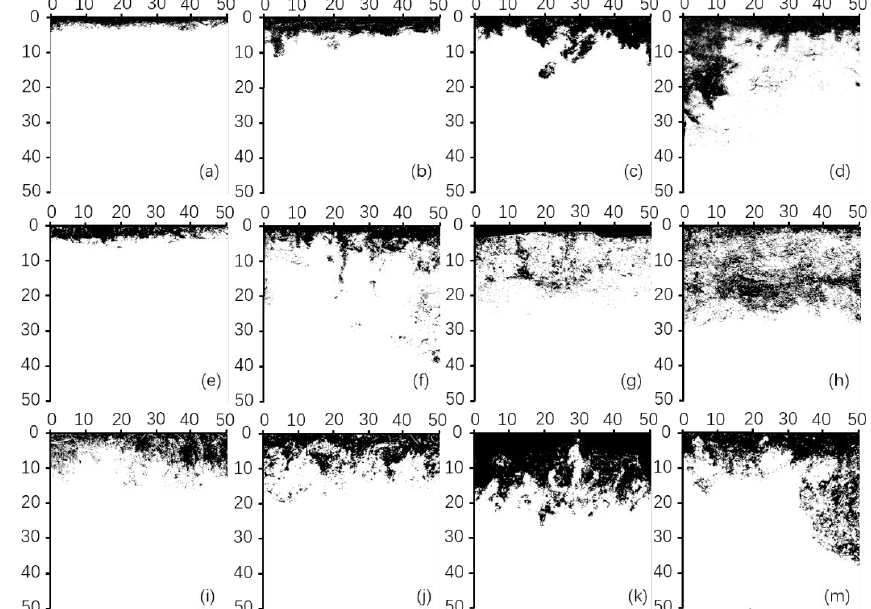
Figure 2. Example dye images for vertical soil sections in the three types of sites under different precipitation amounts. ( a – d ) correspond to the vertical sections of PY at G5, G15, G35, and G55, respectively; ( e – h ) refer to the vertical sections of SF at G5, G15, G35, and G55, respectively; ( i – m ) correspond to the vertical sections of G at G5, G15, G35, and G55, respectively. Among them, G5, G15, G35 and G55 correspond to 5 mm, 15 mm, 35 mm, and 55 mm ponded water infiltration simulations, which simulate the change in ponded water in light rain, medium rain, heavy rain, and storm, respectively.